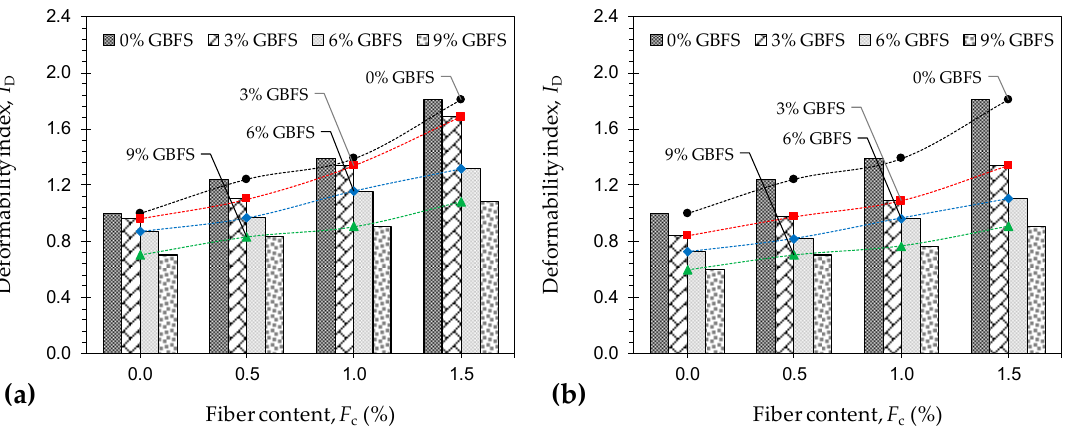
Figure 6. Variations of deformability index I D against JF content for the natural soil and various GBFS-treated samples: ( a ) T c = 7 days; and ( b ) T c = 28 days.